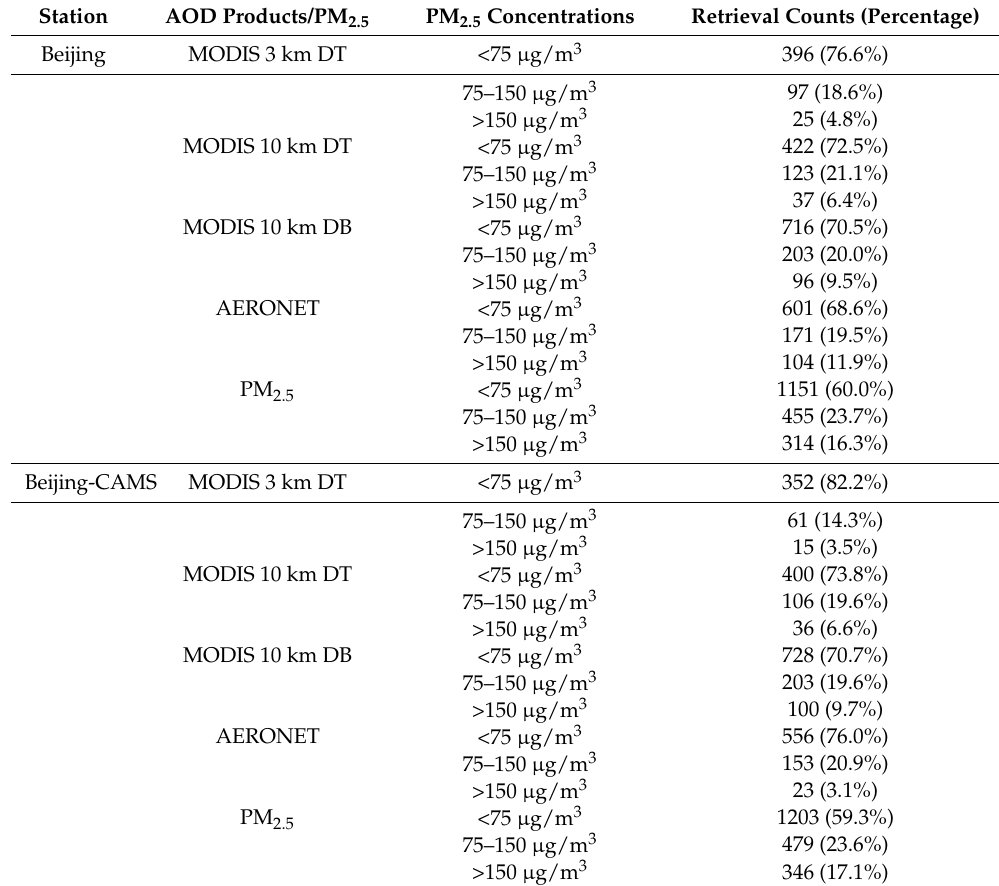
Table 1. Air qualities statistics of successful retrievals of different AOD